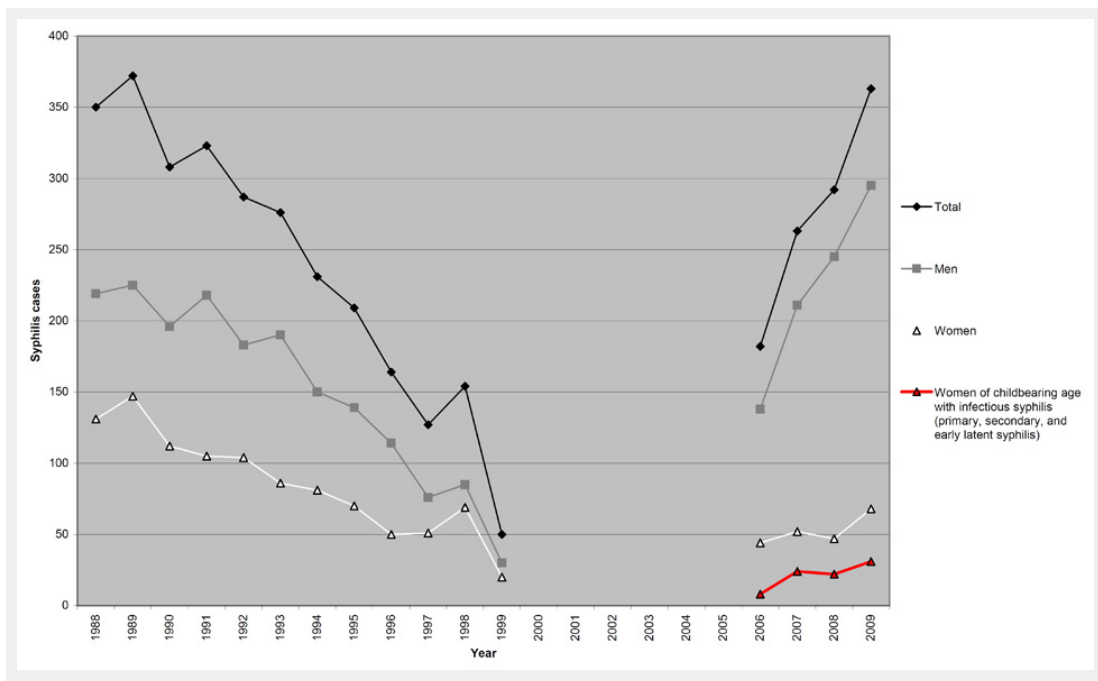
Figure 2 Confirmed infectious syphilis cases among women aged 20–44 years (childbearing age group), 2006–2009 (in red), together with total numbers of laboratory syphilis notification in Switzerland, 1988–2009 (adapted from [5, 6]). 1988–1999: laboratory notifications (Swiss Sentinel Network on STIs); 2000–2005: data not reported for syphilis; Since 2006: laboratory and clinical notifications (SFOPH and attending